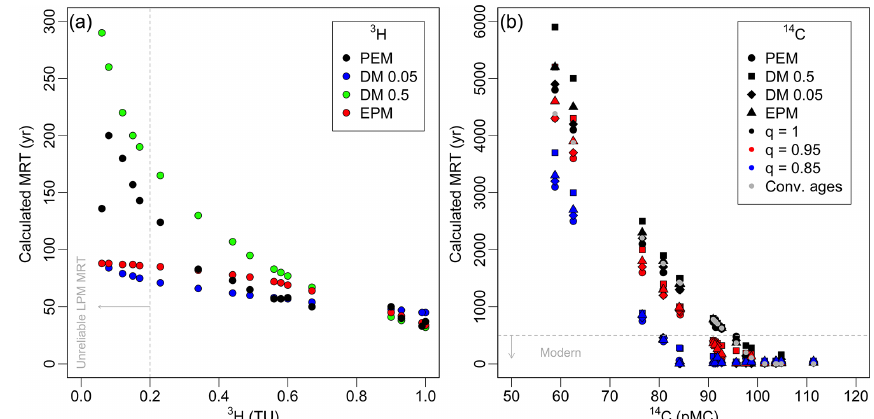
Figure 7. (a) Comparison of calculated MRTs for the partial exponential model (PEM), the dispersion model (DM with dispersion parameters of 0.05 and 0.5) and the exponential piston flow model (EPM) using 3 H. (b) Comparison of calculated MRTs for the partial exponential model (PEM), the dispersion model (DM with dispersion parameters of 0.5 and 0.05) and conventionally calculated carbon ages using the decay function. The model MRTs were also calculated using 14 C dilution models with q factors of 0.95 and 0.85.